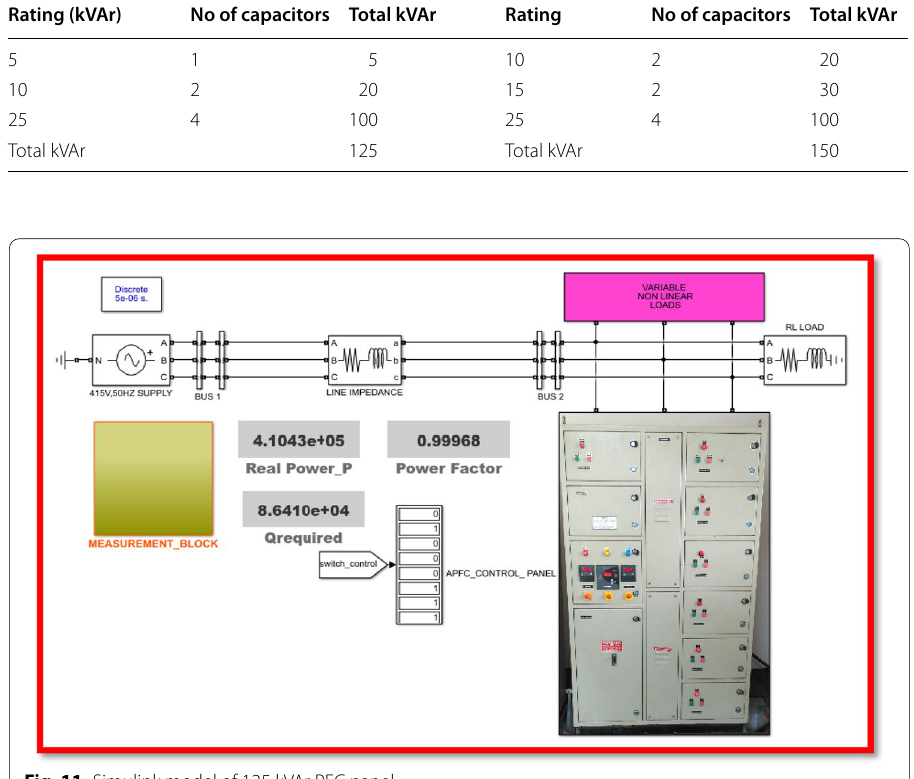
Fig. 11 Simulink model of 125 kVAr PFC